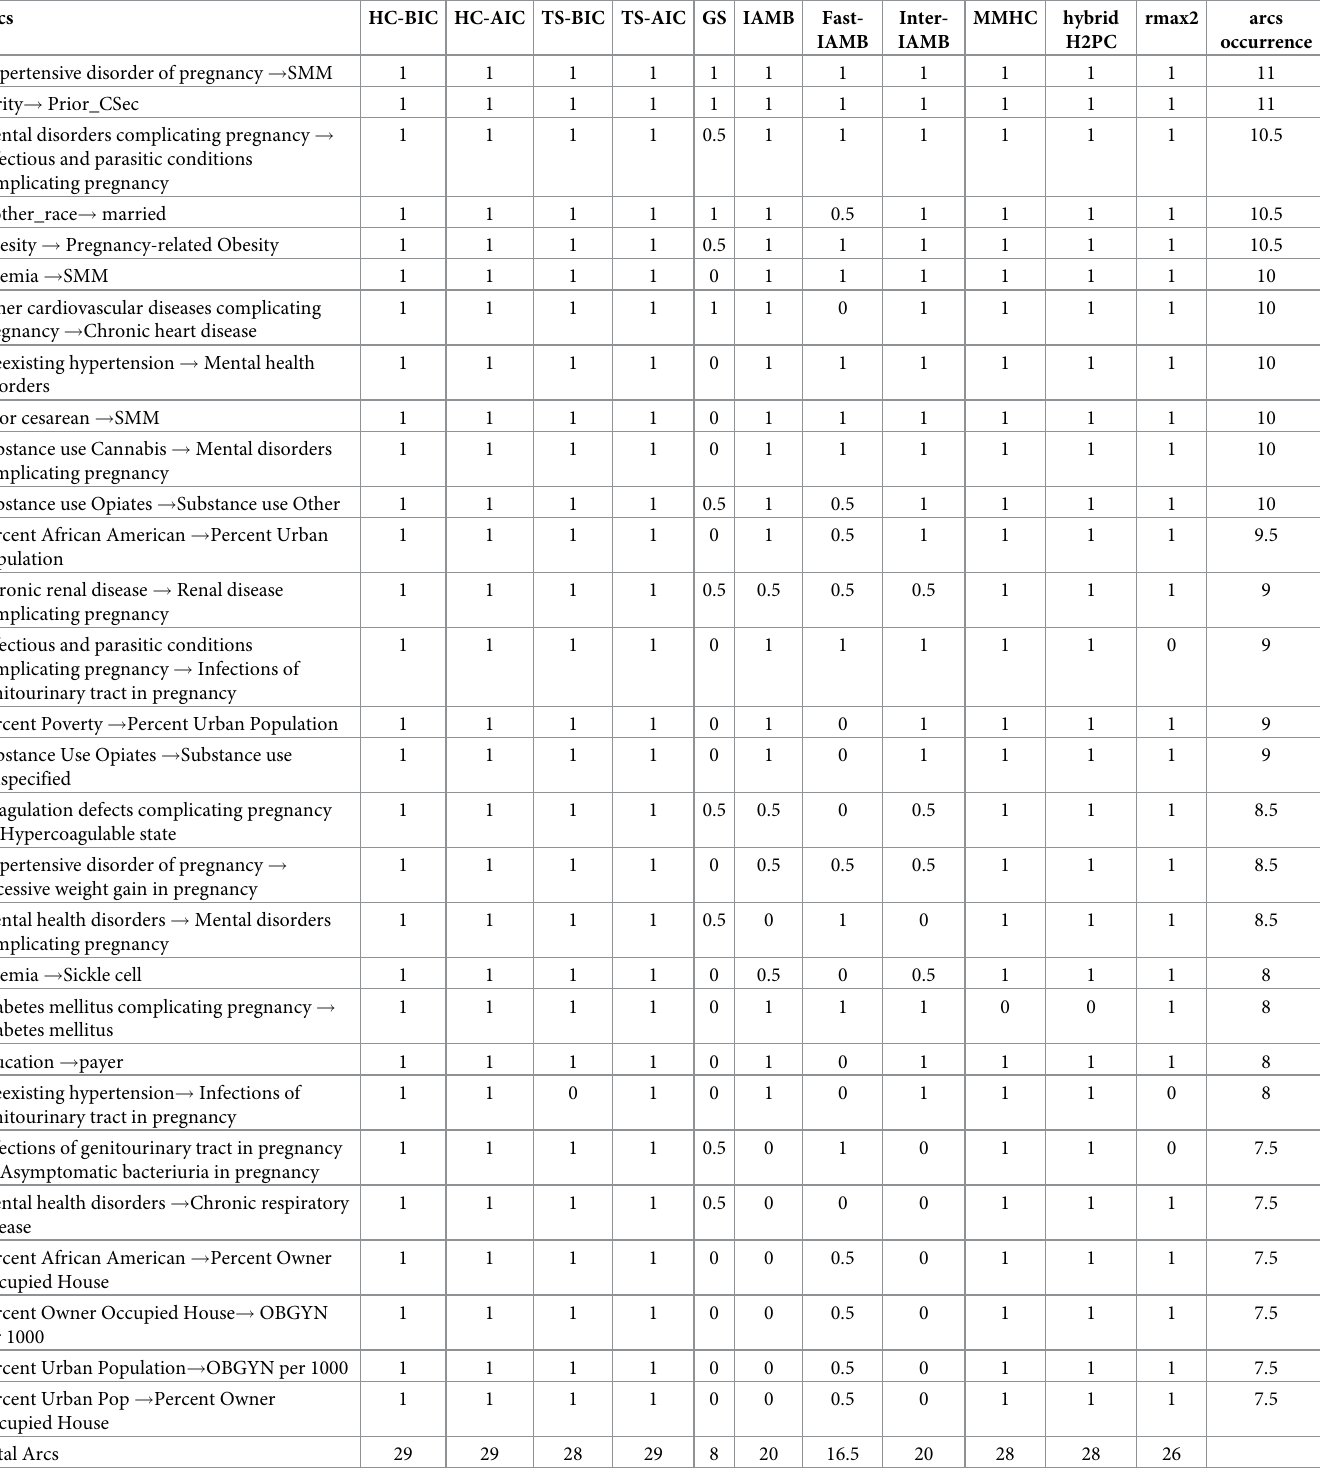
Table 3. Arc strengths obtained using different structure learning